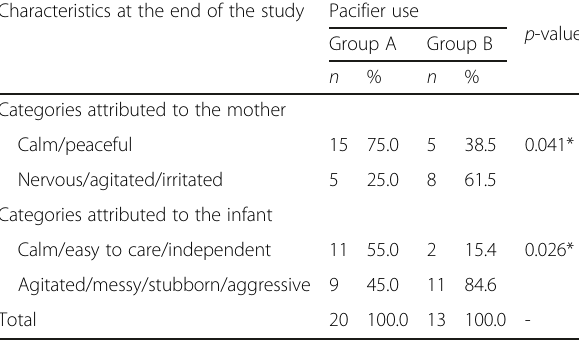
Table 2 Self-reported characteristics of the mothers and their infants at the end of the study with regard to the use of pacifiers over a 2-year